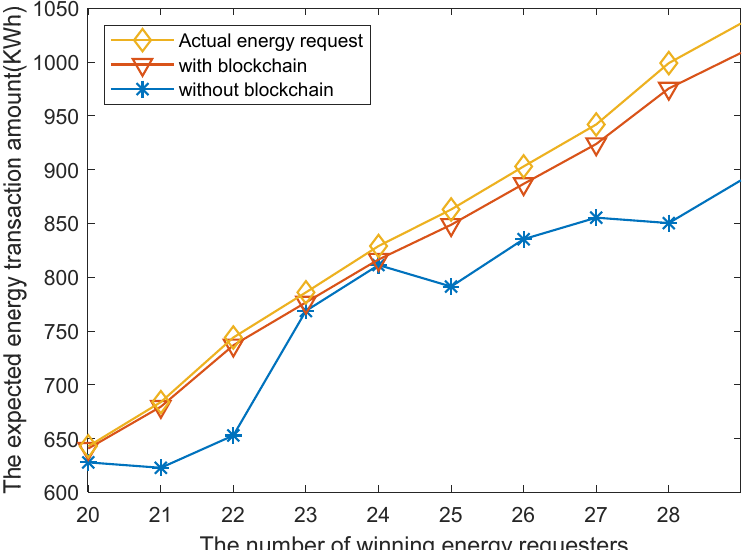
Figure 6. The performance with/without blockchain when the number of energy requesters varies.